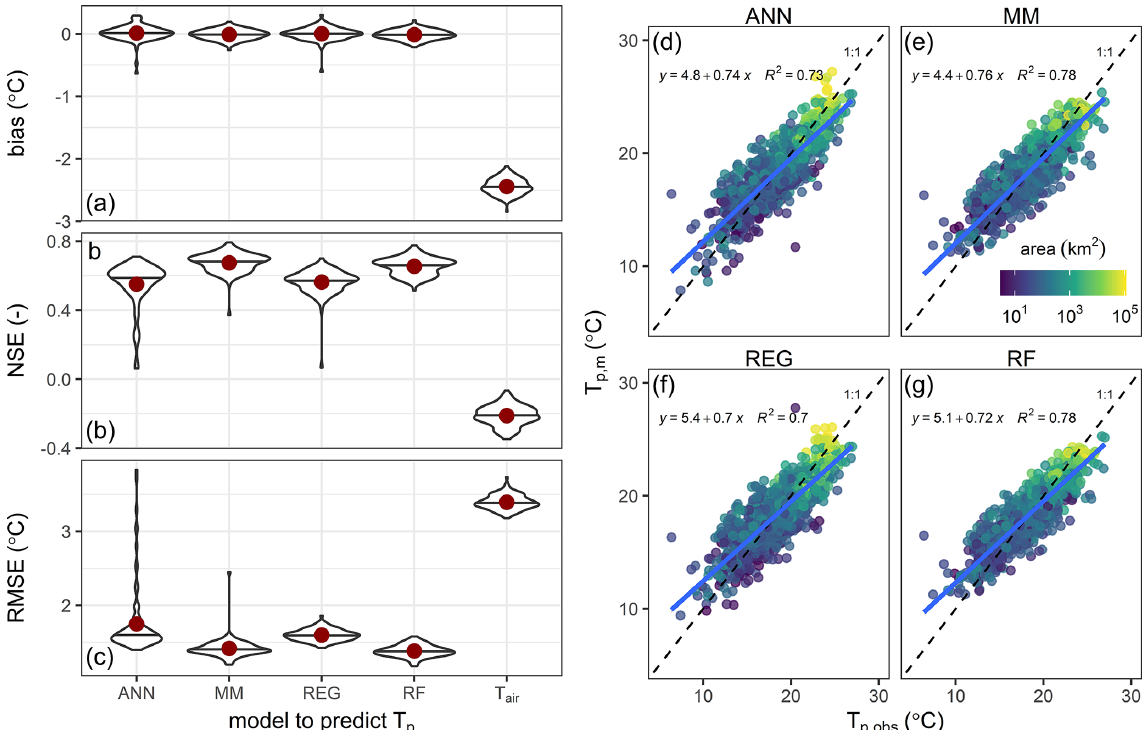
Figure 3. Cross-validation performance metrics for modeled thermal peaks ( T p , m ), where 80% of stations ( n = 1360) were training data, and 20% of stations ( n = 340) were validation data. Violin plots show distributions of 100 replicates of training-validation data for each model’s performance metrics: (a) bias relative to T p , ref , (b) NSE, and (c) RMSE of T p , m relative to observed T p . Horizontal lines indicate sample medians, and red points indicate sample means. (d–f) T p , m vs. T p , obs for each model colored by watershed area at the site. Simple linear regression results ( n = 1700) are shown in blue with comparison to a 1 : 1 line